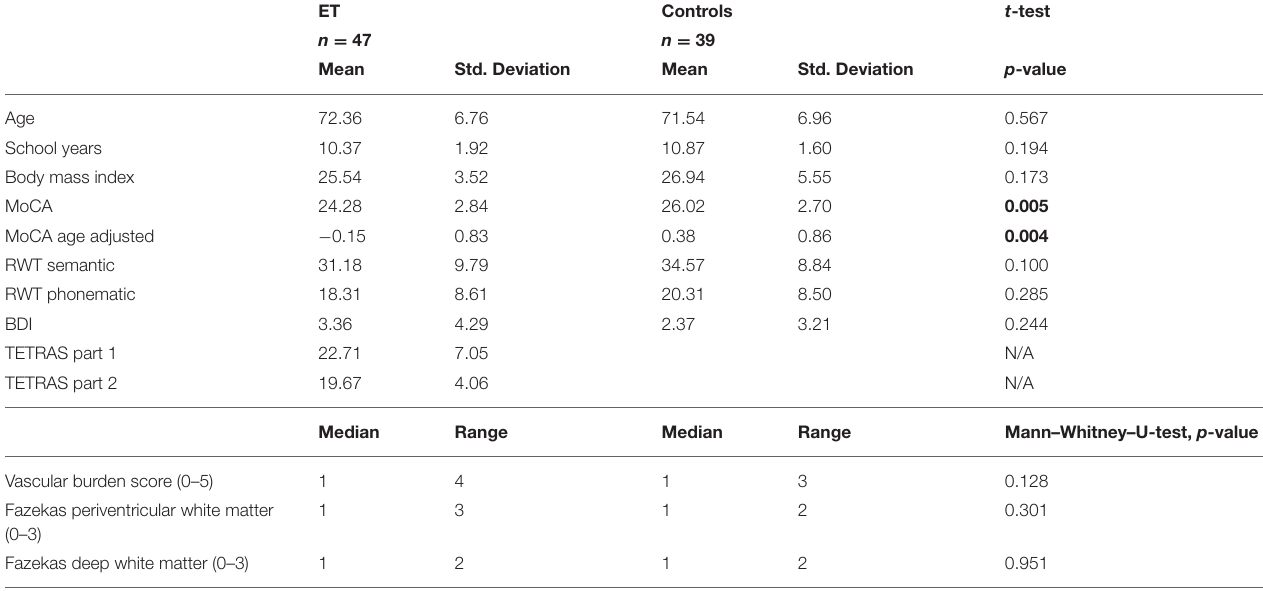
TABLE 1 | Baseline characteristics.